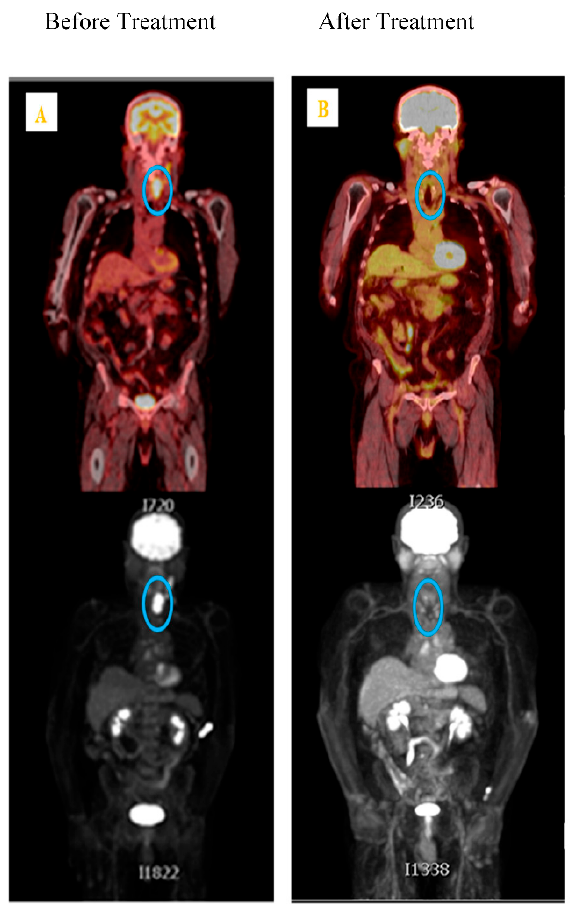
Figure 1. PET scan of Male pyriform fossa squamous cell carcinoma stage T4aN2bM0 patient without surgery, treated with radical radiotherapy delivery 70Gy/35# over 7 weeks followed by cisplatin 100 mg/msq given on week 1, week 4 and week 7 of radiotherapy. ( A ) Left panel blue circle showing the tumour spot before treatment on the 23 October 2014; ( B ) Right blue circle panel showing the antitumor effect of radical radio chemotherapy after treatment, showing no regional palpable lymphadenopathy, oral capsule was clear, showing no local recurrence, patient follow up after two years on 11 May 2017.